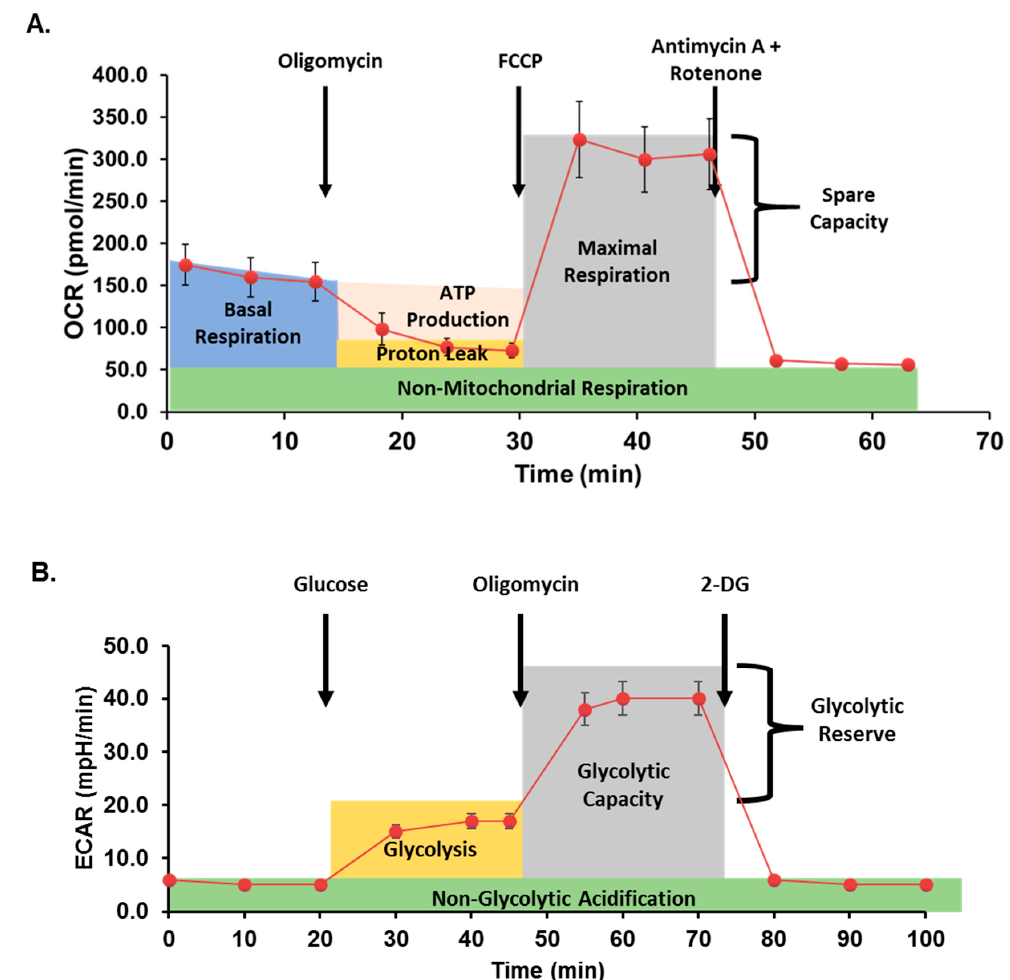
Figure 2. Seahorse assay method schematic. ( A ) In mitochondrial stress assays, oxygen consumption rate (OCR) is measured before and after additions of oligomycin (an inhibitor of ATP synthase), carbonyl cyanide p-trifluoromethoxy-phenylhydrazone (FCCP; proton gradient uncoupler), and antimycin A + rotenone (inhibitors of mitochondrial complex I and III, respectively) to quantify mitochondrial respiration. ( B ) In glycolytic stress assays, extracellular acidification rate (ECAR) is measured after inducing glycolysis, inhibiting ATP synthase, and finally inhibiting